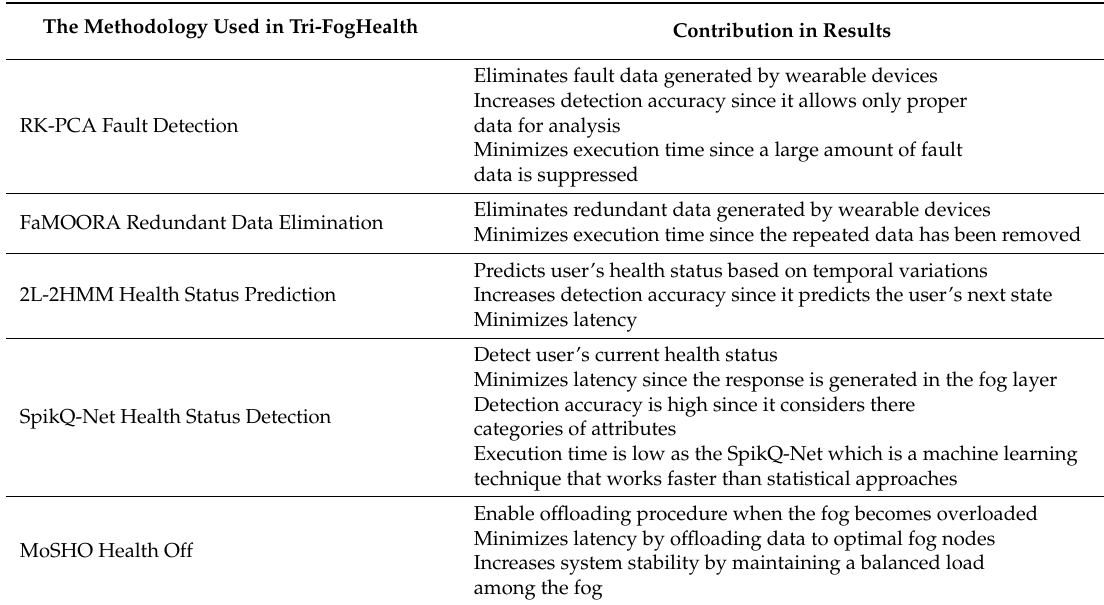
Table 8. Summarization of Proposed